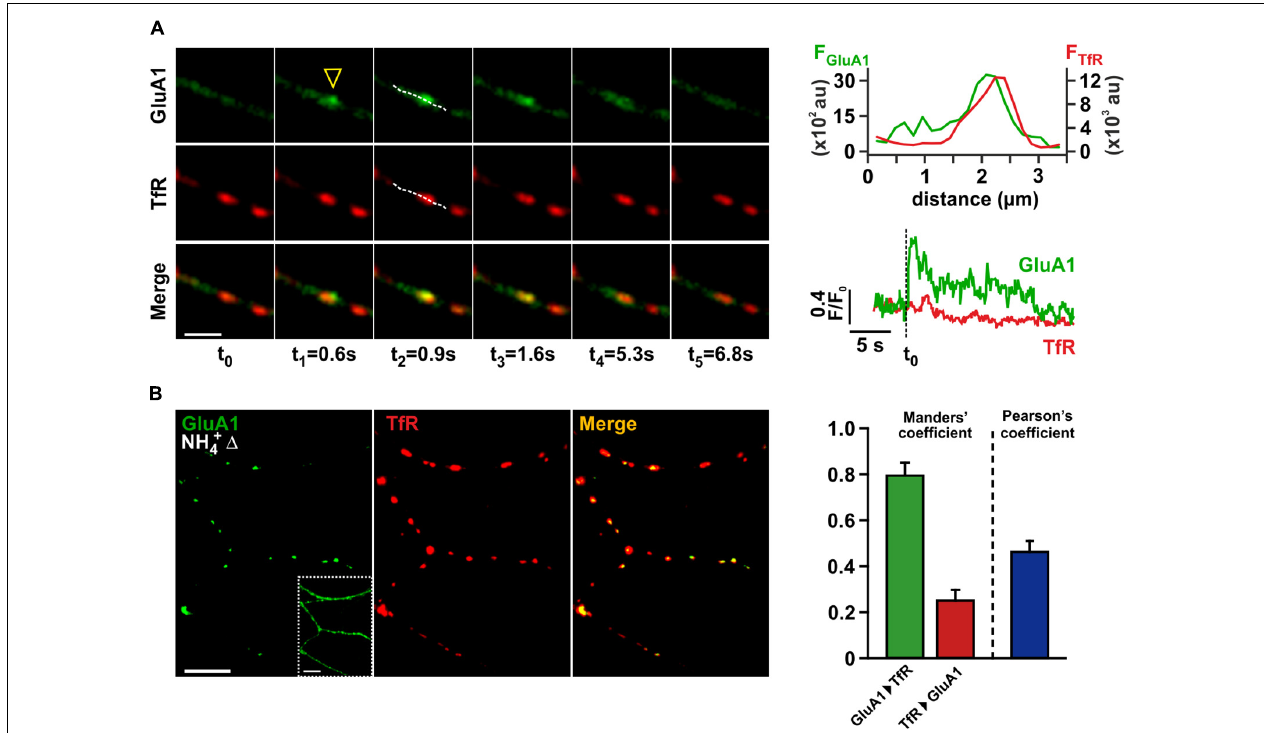
FIGURE 1 | Kiss-and-run fusion of recycling endosomes underlies spontaneous AMPAR insertion in dendrites of hippocampal neurons. (A) Time series of consecutive images depicting an exemplary dendritic fusion event (scale bar = 4 µ m). SEP-GluA1 fluorescence (green) and TfR-tagRFPt fluorescence (red) are shown in the upper and middle row, merged images in the bottom row. The fusion site is marked by a yellow arrowhead. Fusion events were classified as “RE-associated,” if line scans (hatched lines in images at t 2 ) indicated a vast overlap of both signal peaks (upper right panel) . Temporal profiles for red and green signals in a region of interest enclosing the site of the fusion event are depicted in the lower right panel. (B) Intracellular AMPAR pools were analyzed by application of NH 4 + , allowing for visualization of intracellular AMPAR signals in a difference picture (NH 4 + (cid:49) , left image; scale bars = 10 µ m). The inset shows the same dendrites before NH 4 + -application, outlining the geometry of the dendritic arborization. Recycling endosomes within the same field of view were marked by TfR-tagRFPt (middle image). In order to quantify the signal overlap between tagged AMPARs and TfR-marked recycling endosomes, we calculated both Manders’ coefficents and Pearson’s coefficient ( n = 11) (right panel)